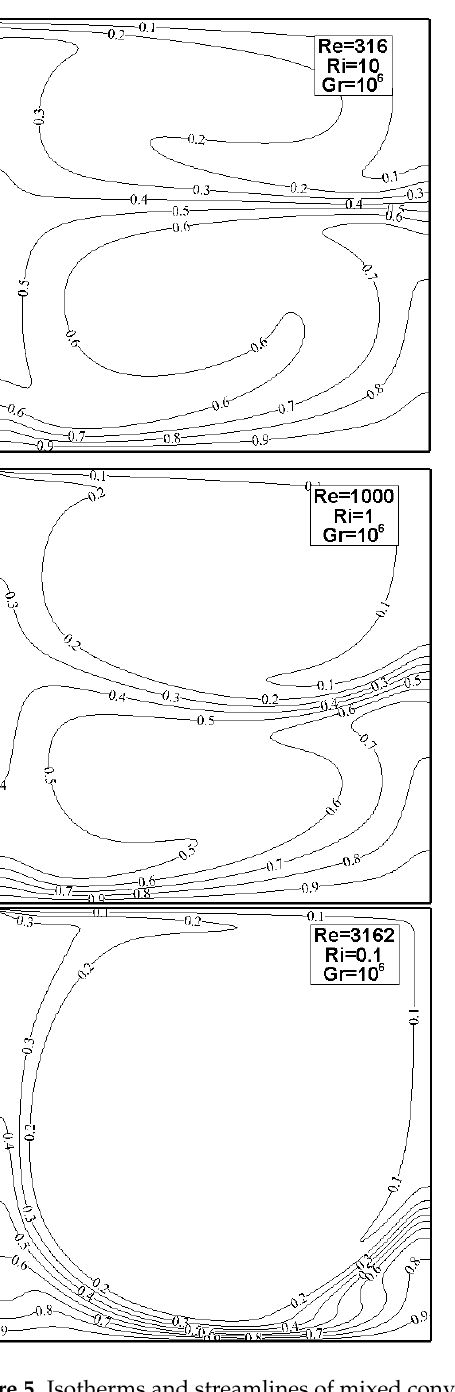
Table 5. Comparison of average Nusselt number on hot wall for the mixed convection in lid ‐ driven cavity.